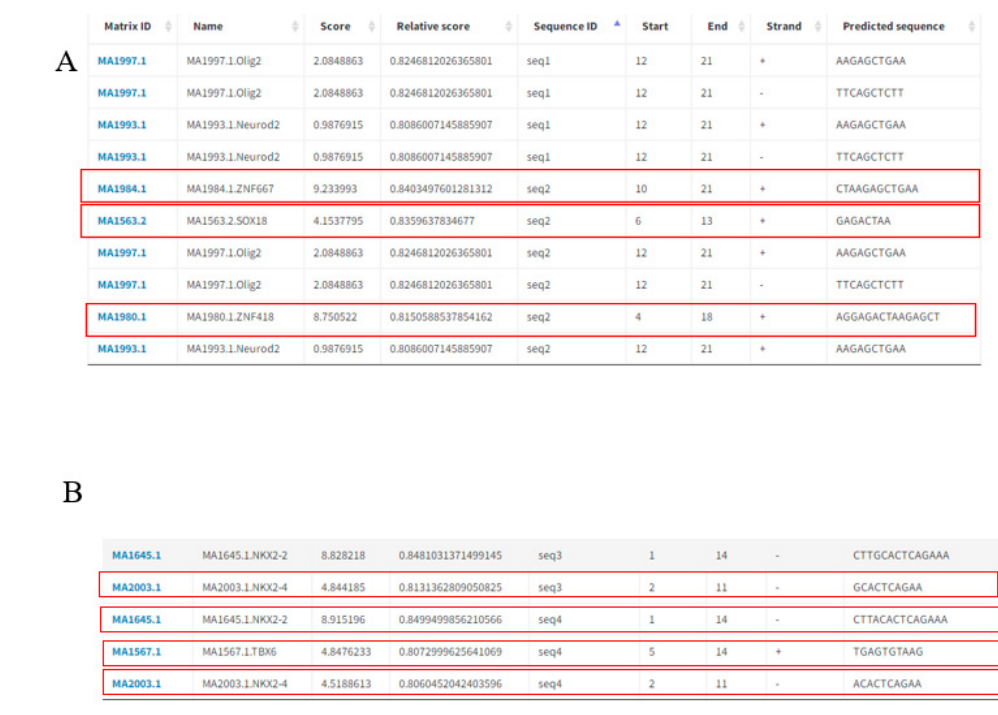
Figure 4. Predicted transcription factors associated with the PPP2R5C g.65977743C>T and SLC39A5 g.50676693T>C polymorphisms (Red box: transcription factor that binds to the mutation site). ( A )